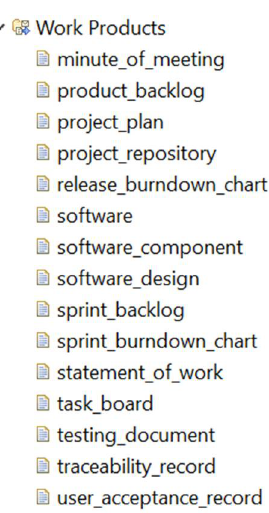
Figure 8. Examples of tasks in VSE Composer.